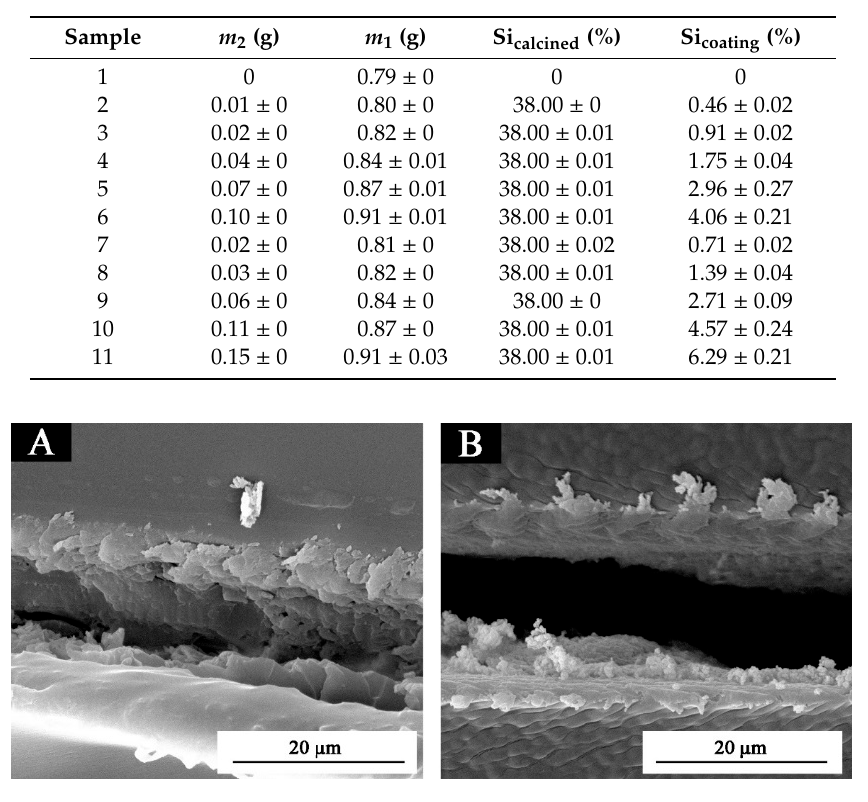
Figure 3. The cross-section SEM images of the waterborne coatings with ( A ) 5.0% WSPALR and ( B ) 5.0% calcined WSPALR.